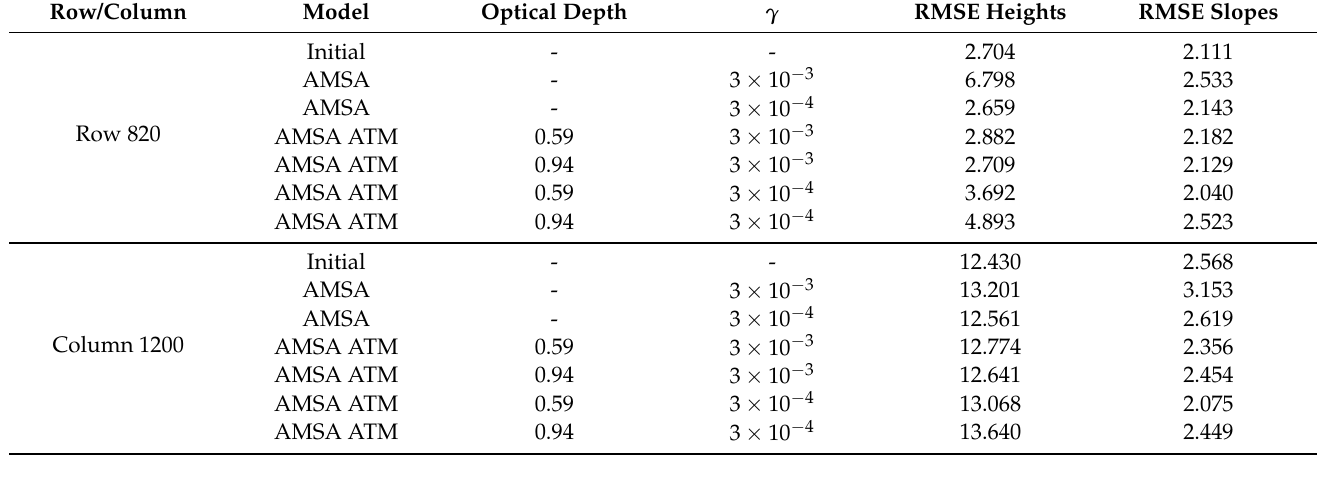
Table 7. Comparison of the Root Mean Square Errors (RMSEs) for the examined lines in the DEMs based on image K13_058475_2232_XN_43N103W. γ = 3 and γ = 3 10 − 4 is the best value for the AMSA ATM model determined by the heuristic described × in Section 2.3.